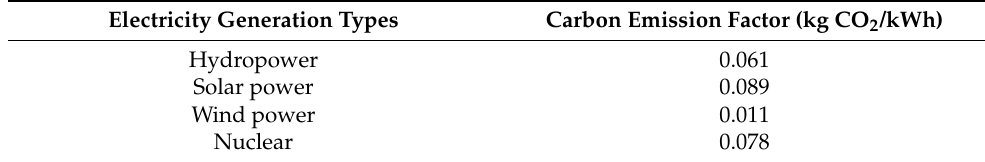
Table A7. Carbon emission factors of clean energy resources.